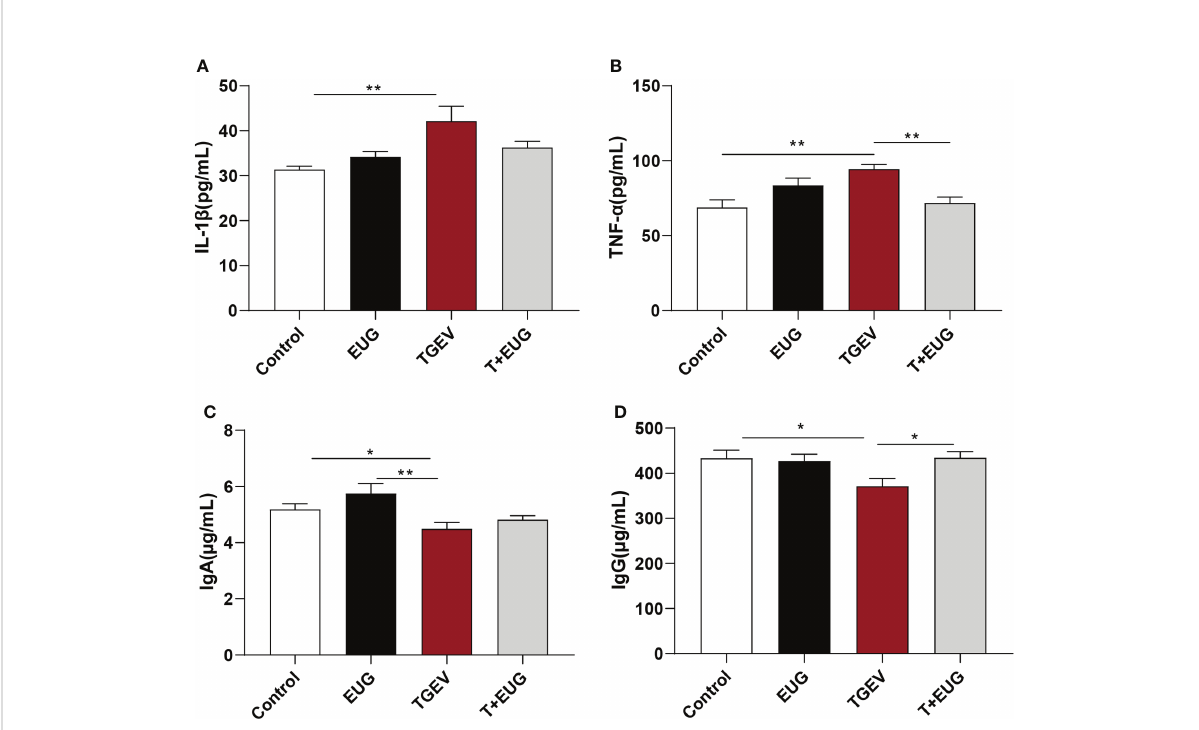
FIGURE 2 Effects of eugenol on serum in fl ammatory factors and immunoglobulin contents in TGEV-infected weaned piglets. (A – D) The levels of IL-1 b , TNF- a , IgA and IgG in serum were detected by ELISA. Data were expressed as mean ± SEM. * p < 0.05, ** p <